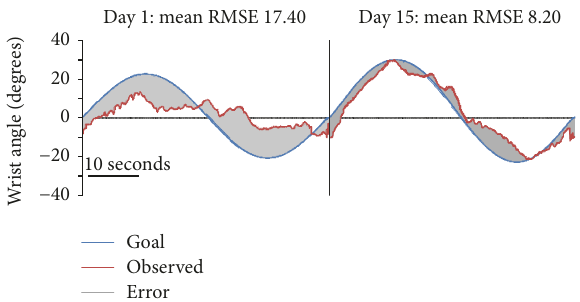
Figure 5: Mean tracking performance. Mean tracking performance from the first training session to the last training session. The solid blue line indicates the target sine waveform. The solid red line indicates the observed tracking. The grey shaded region indicates the tracking